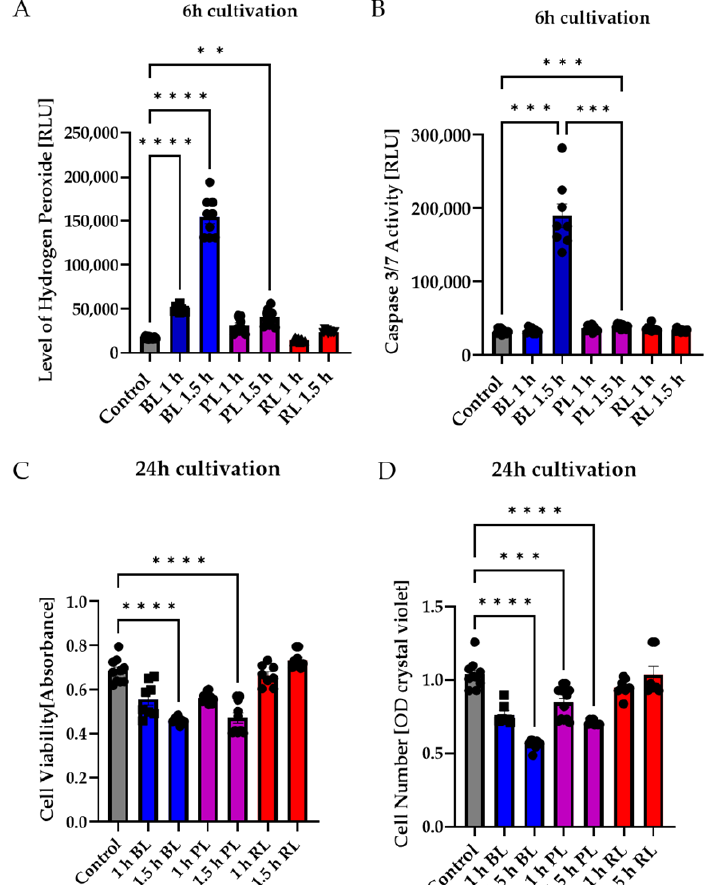
Figure 3. Blue light exposure, in particular, led to apoptosis in primary Müller cell-derived cells, whereas red light had no toxic effect. Müller cell-derived cultures (MCs) were exposed to blue light (BL, 15 mW/cm 2 ), purple light (PL, a combination of blue and red light, 15 mW/cm 2 ), or red light (RL, 630 nm, 3 mW/cm 2 ) for 1 or 1.5 h and further cultivated for 6 or 24 h. ( A ) Oxidative stress levels were significantly induced 6 h after BL or PL exposure, but not RL exposure. ( B ) Caspase 3/7 activity was slightly induced due to PL exposure and strongly induced after BL exposure. ( C ) Cell viability significantly decreased 24 h after BL and PL exposure. Again, RL exposure did not affect MCs. ( D ) BL and PL exposure led to a significant and strong decrease in cell numbers 24 h after exposure, whereas RL exposure did not affect MC cell numbers. Bar graphs represent the mean values and SEM. The experiments were repeated three times with similar results. Statistical differences are indicated as follows: ** p < 0.01, *** p < 0.001, and **** p < 0.0001 compared to control, according to Welch’s one-way